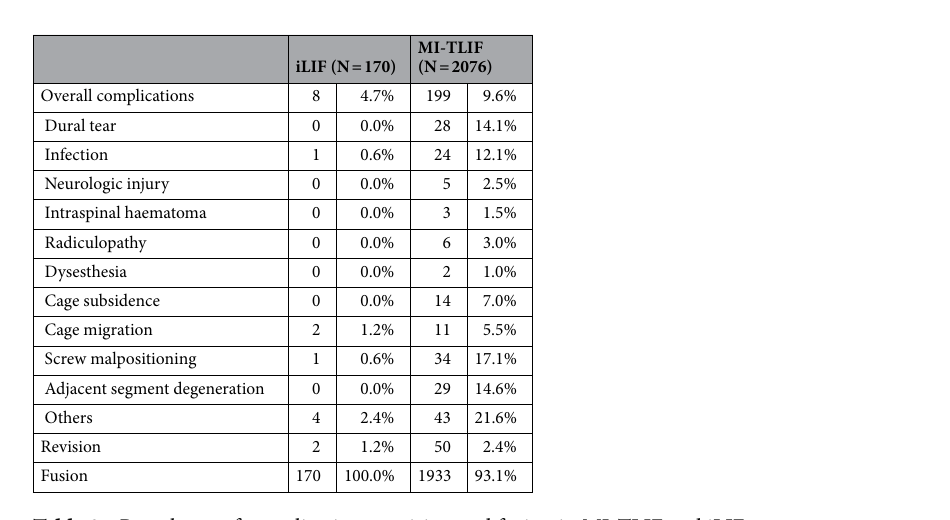
Table 8. Prevalence of complications, revision and fusion in MI-TLIF and